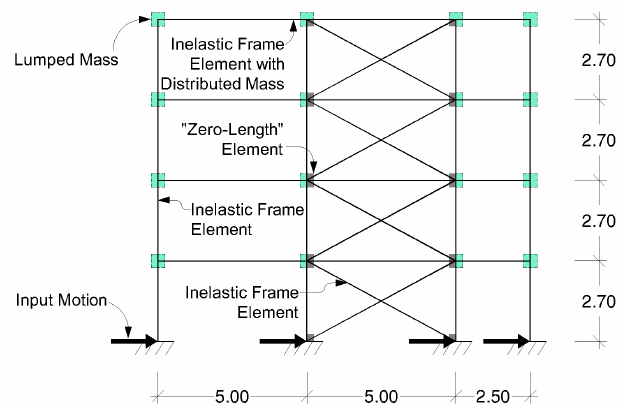
Figure 7. General characteristics of the numerical model developed for the DCM frame.